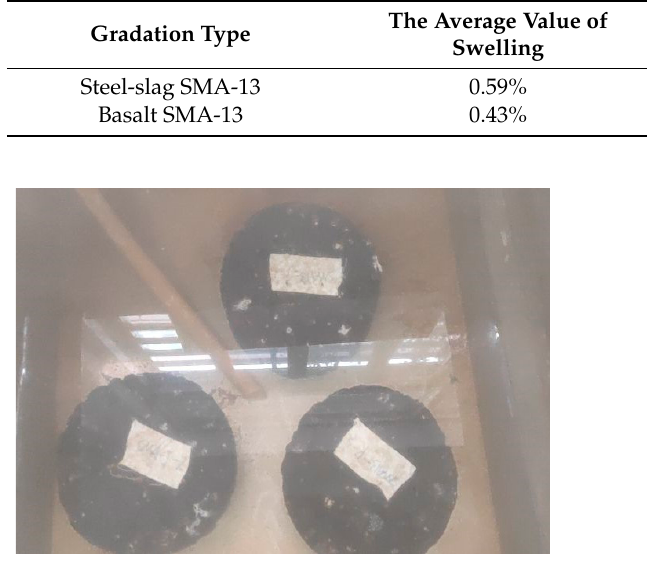
Figure 14. Swelling characteristic test. Table 7. Expansion test of asphalt mixture.